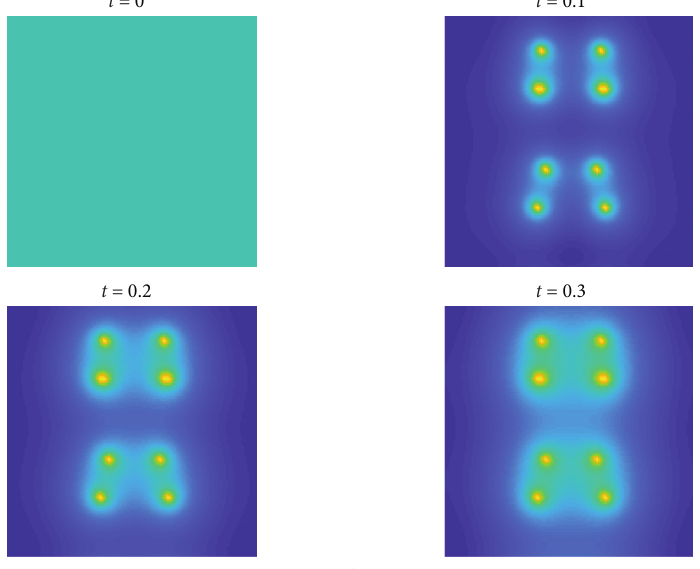
Figure 15: Numerical solution and Turing pattern of Experiment 2 with initial condition u ( x,y, 0 ) � ( 12/25 ) − sin ( 10 x 2 − 510 )− sin ( 10 y − 220 ) and v ( x,y, 0 ) �